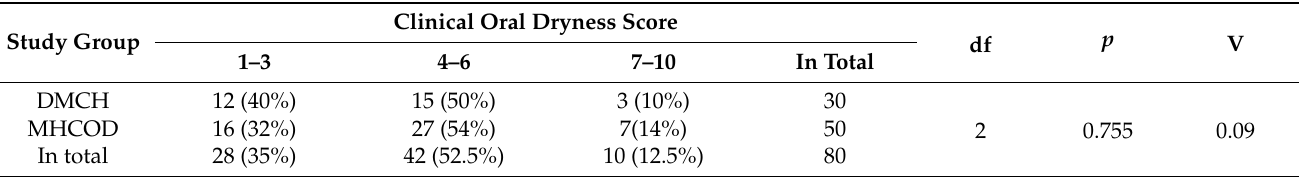
Table 10. The results of Clinical Oral Dryness Score in both